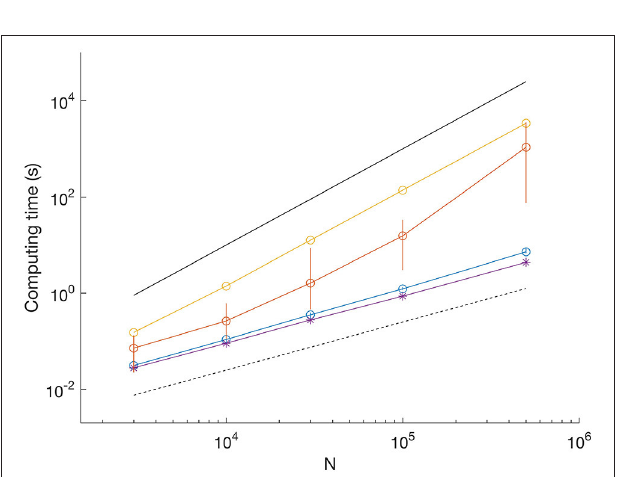
FIGURE 4 | Event detection using different algorithms on simple simulated data. (A) Top; part of the raw input data (gray) and Markov states (black); lower panels show states detected using different methods (input data are smoothed for easier comparison). Blue: states detected using threshold crossing algorithm applied on low-pass filtered data. Asterisk indicates a false detection. Green: states detected using Viterbi-algorithm as implemented in QuB. Cyan: states detected using J-SMURF. Two asterisks indicate false segmentations. Red: states detected using MDL-algorithm. (B) Distribution of step-lengths in logarithmic bins. Black, step lengths of input; blue, threshold crossing on optimally low-pass filtered data ( F Ny /40 ); green, Viterbi; red, MDL; cyan, J-SMURF (rescaled). Black dashed lines indicate regions highlighted in (C) . (C) Close-up view of distribution of step lengths, colors as in (B)